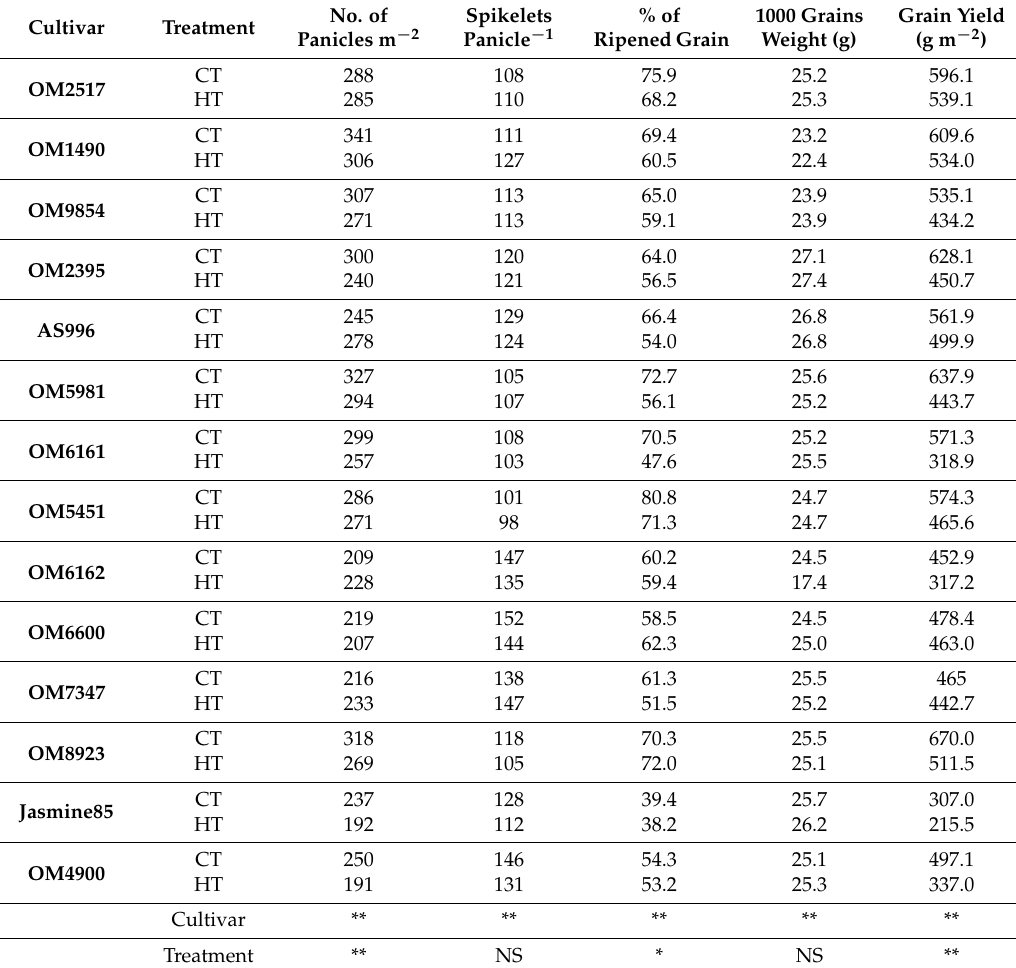
Table 2. Yields and yield components of 14 Vietnamese cultivars under control and high temperature treatments in 2015.